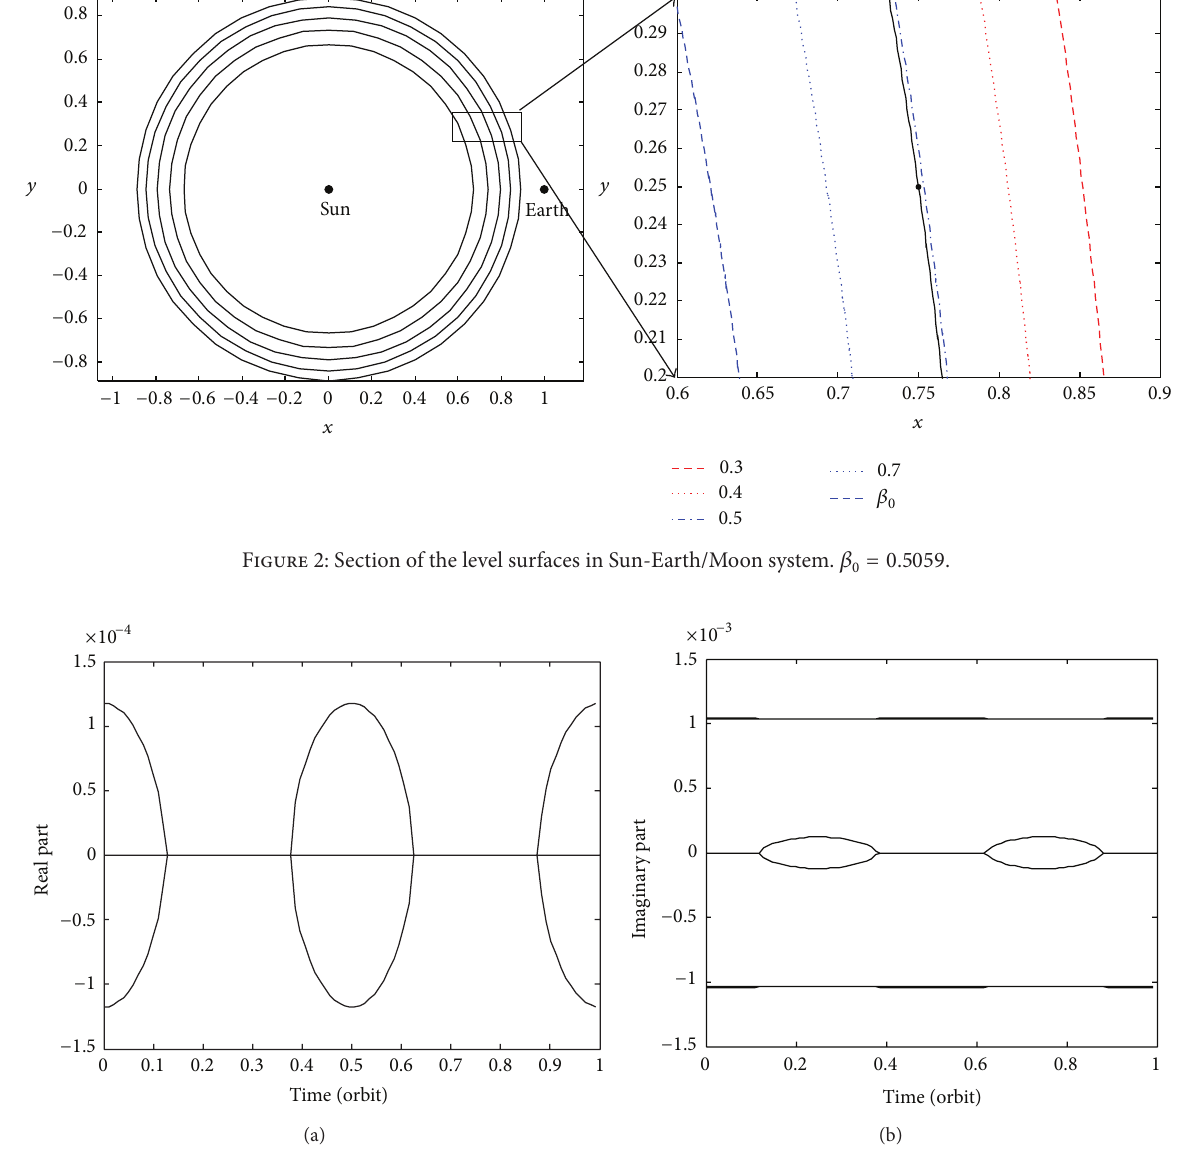
Figure 3: Topological type of the equilibrium in the modified uncontrolled system: (a) the time history of real part of the equilibrium during the orbital period; (b) the time history of imaginary part of the equilibrium during the orbital